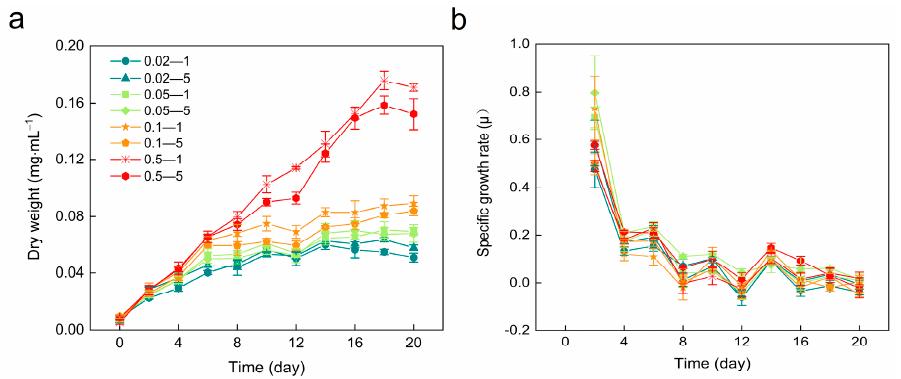
Figure 1. The changes in biomass ( a ) and specific growth rate ( b ) of C. ovalisporum in the different treat- ments.